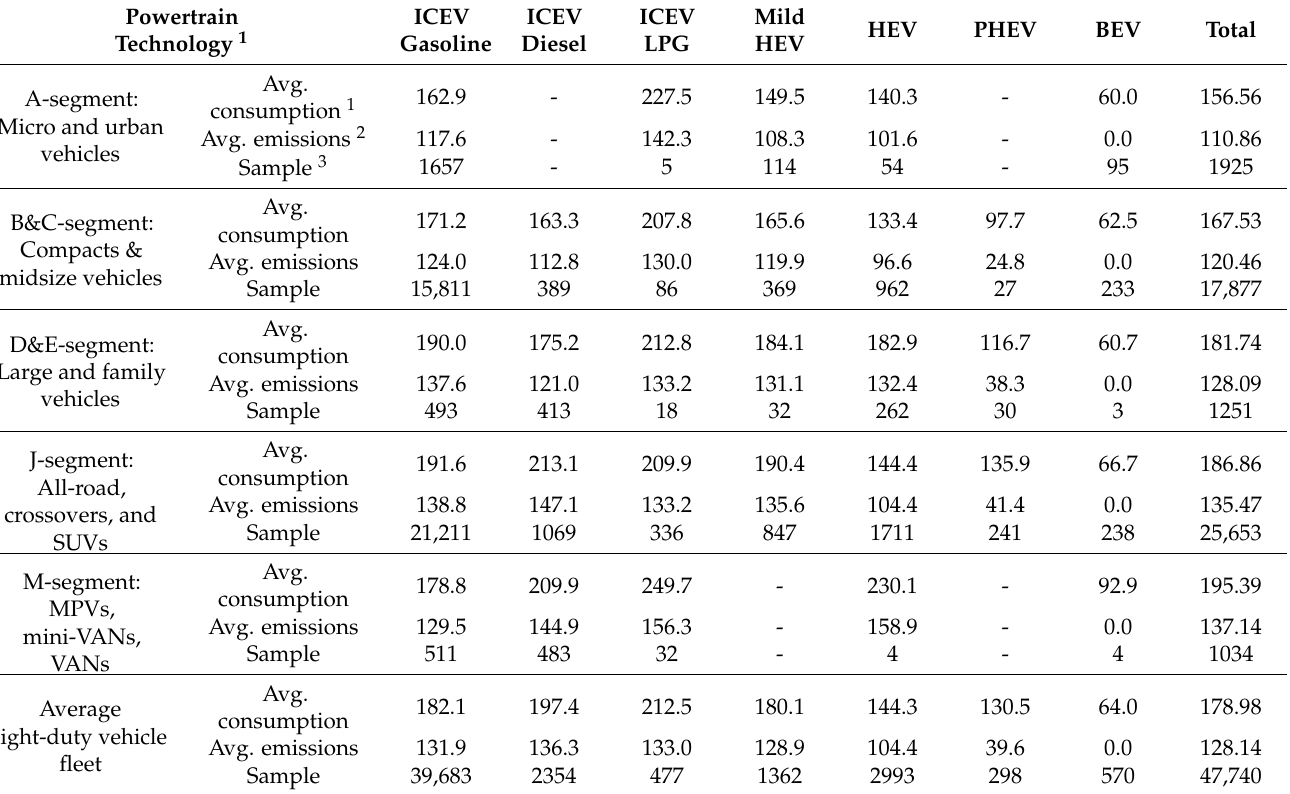
Table 4. Car inventory by the average consumption and emissions by technology and